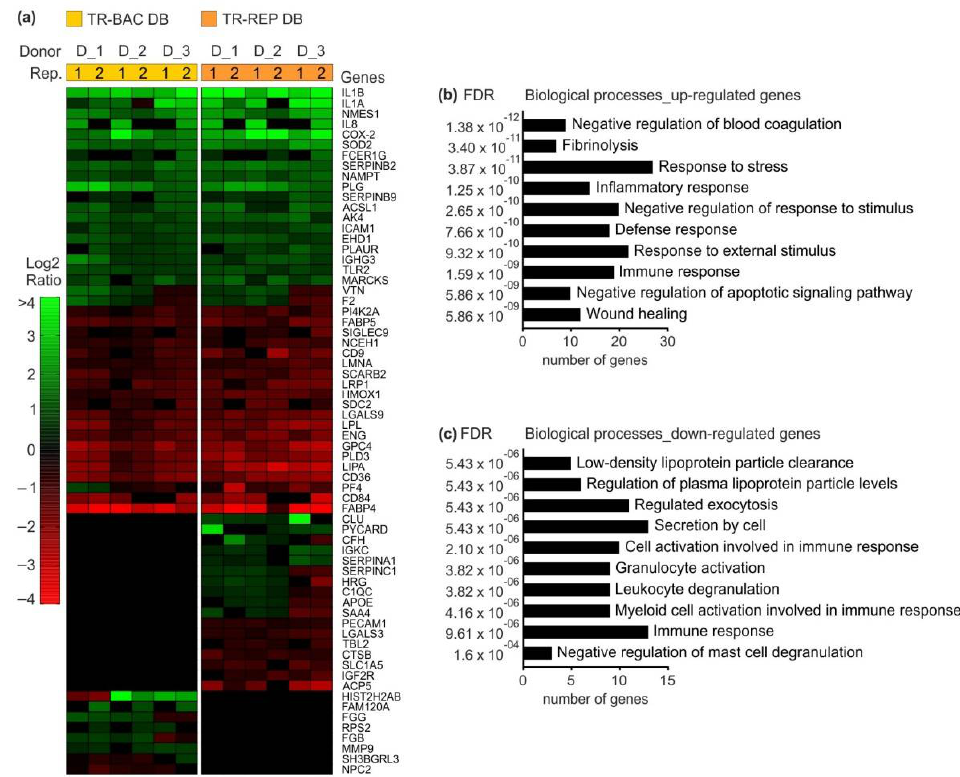
Figure 7. Proteome analysis from monocytes exposed to DB. ( a ) Heatmap of proteins which are differentially regulated in monocytes exposed to both, PC-negative Towne-BAC (TR-BAC DB) and PC-positive TowneUL130rep-ΔGFP (TR-REP) DB. Each row represents a protein and two columns represent the two technical replicates (1;2) of one donor (D_1). Regulated proteins with a minimum Log2Ratio of ±0.58 in at least one technical replicate in every donor were hierarchically arranged. The log2Ratio is represented with a color gradient. Green indicates up-regulation, red indicates down-regulation. Black areas represent values that did not reach the threshold of ±0.58. (B + C) Gene ontology (GO) enrichment analysis, performed using the STRING database (Version 11.5), indicated up- ( b ) and down-regulated ( c ) terms of biological processes. The terms were arranged according to the False Discovery Rate (FDR). The y -axis represents biological processes categories with the corresponding p -values, while the x -axis indicates the number of genes involved in each